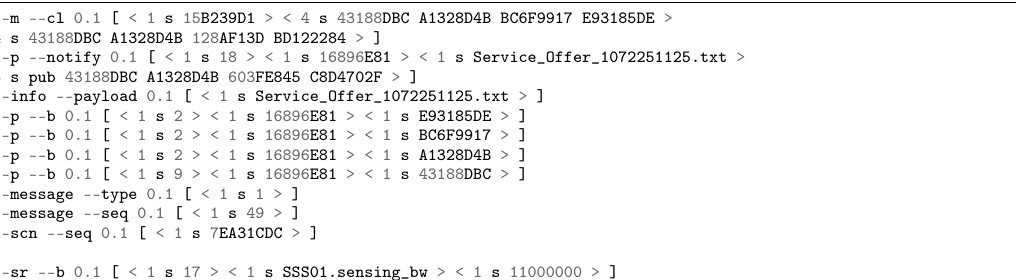
Figure 15. Log of SSS service offer to RMS.